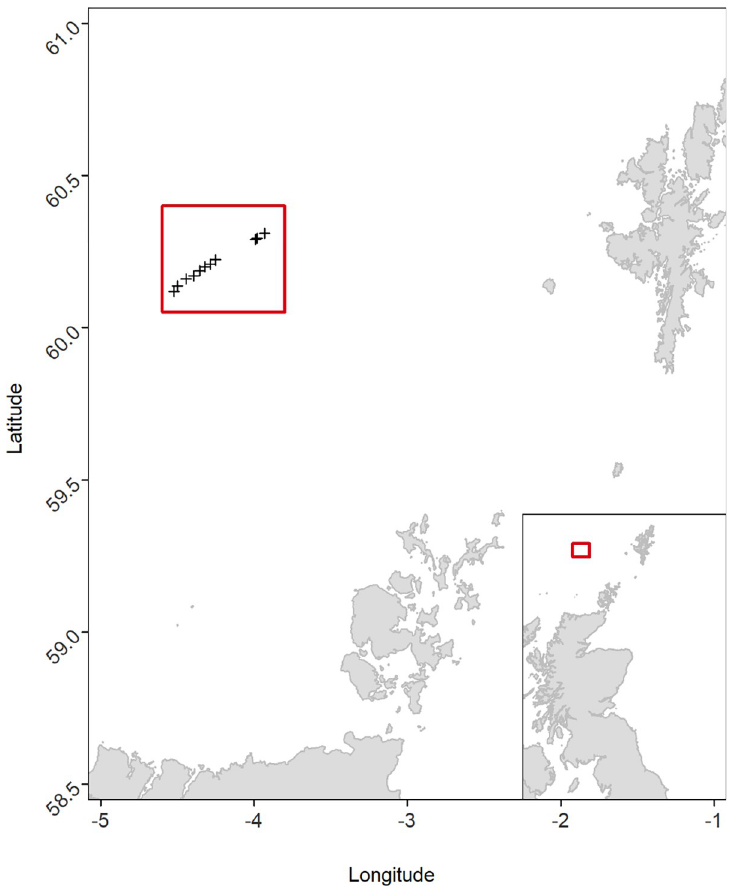
Fig 2. Location of data collection (red square), which took place on a longliner targeting European Hake in Scottish waters, between February and March 2020. Each black cross indicates the start of a longline deployment with TDRs attached.